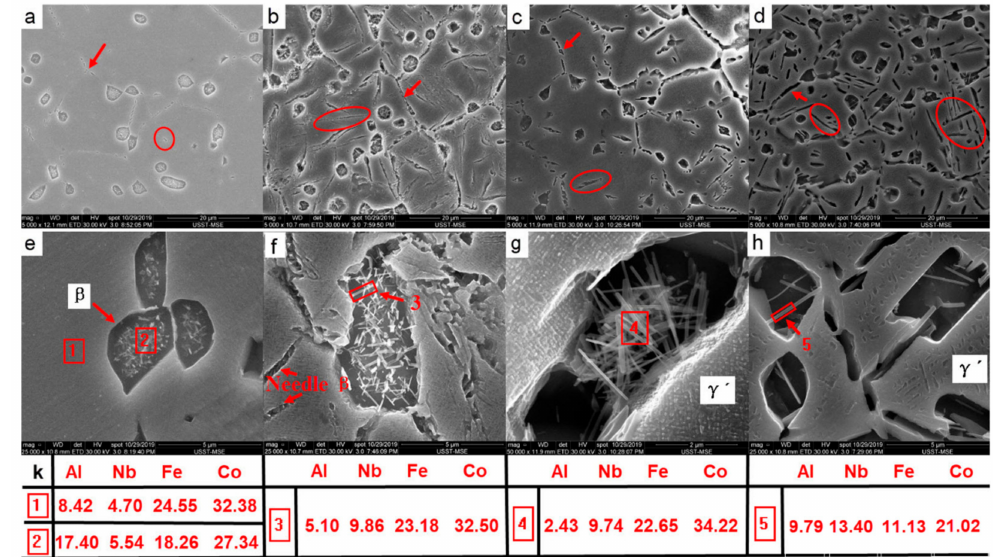
Figure 4. SEM micrographs of the β phase for Inconel 783 alloy bolts with di ff erent aging temperatures and times: ( a , e ) 650 ◦ C—1000 h, ( b , f ) 650 ◦ C—20,000 h, ( c , g ) 700 ◦ C—1000 h, ( d , h ) 700 ◦ C—20,000 h, and ( k ) EDS analysis of the β phase in micro zones 1,2,3,4,5,